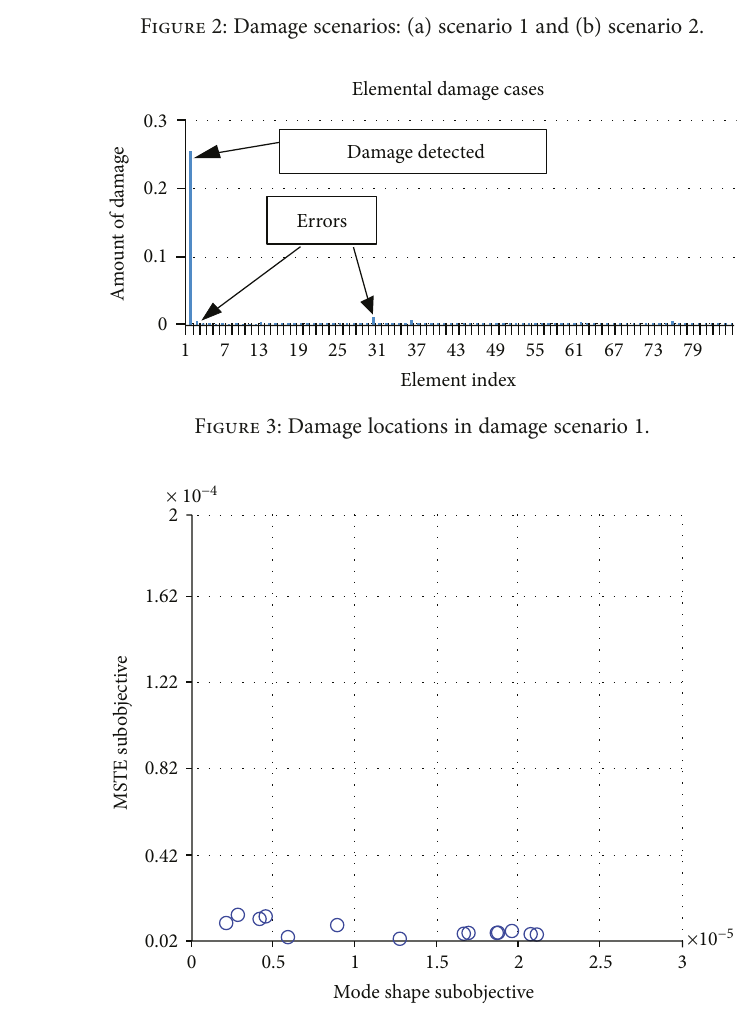
Figure 4: Optimal front obtained from MOLFPSO/TOPSIS in damage scenario